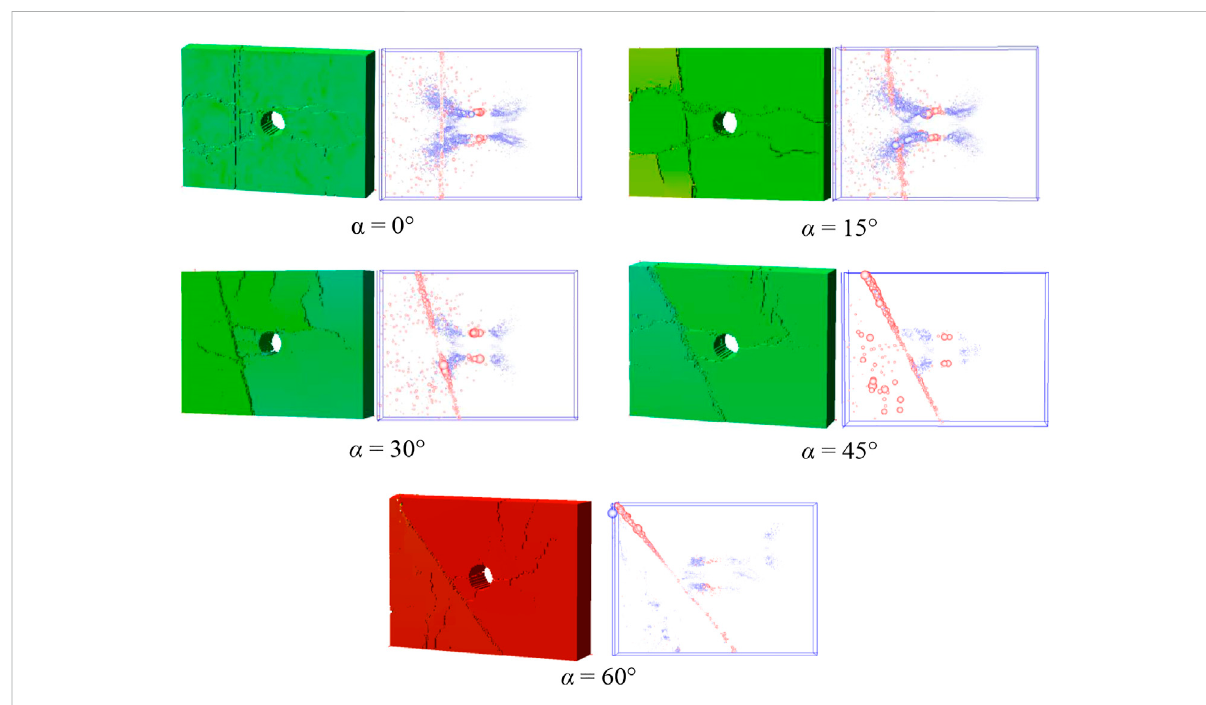
FIGURE 13 Failure patterns and AE distribution of jointed rocky with a pre-existing hole under different